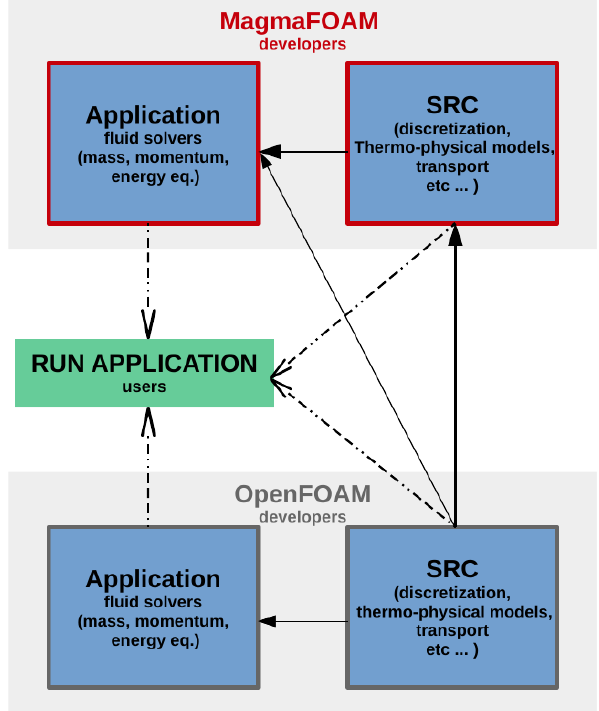
Figure 2. MagmaFOAM–OpenFOAM coupling